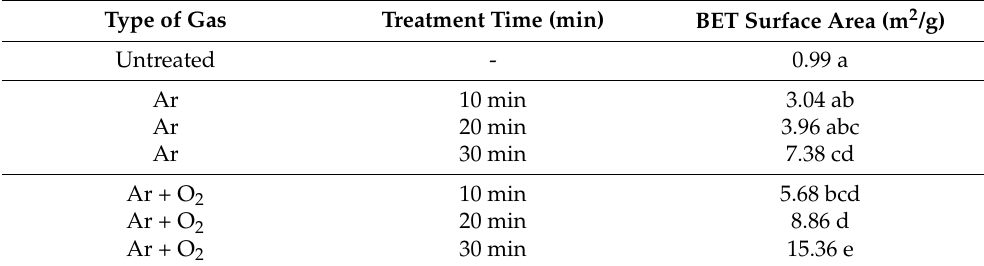
Table 5. Surface area of bamboo fiber treated with plasma via BET